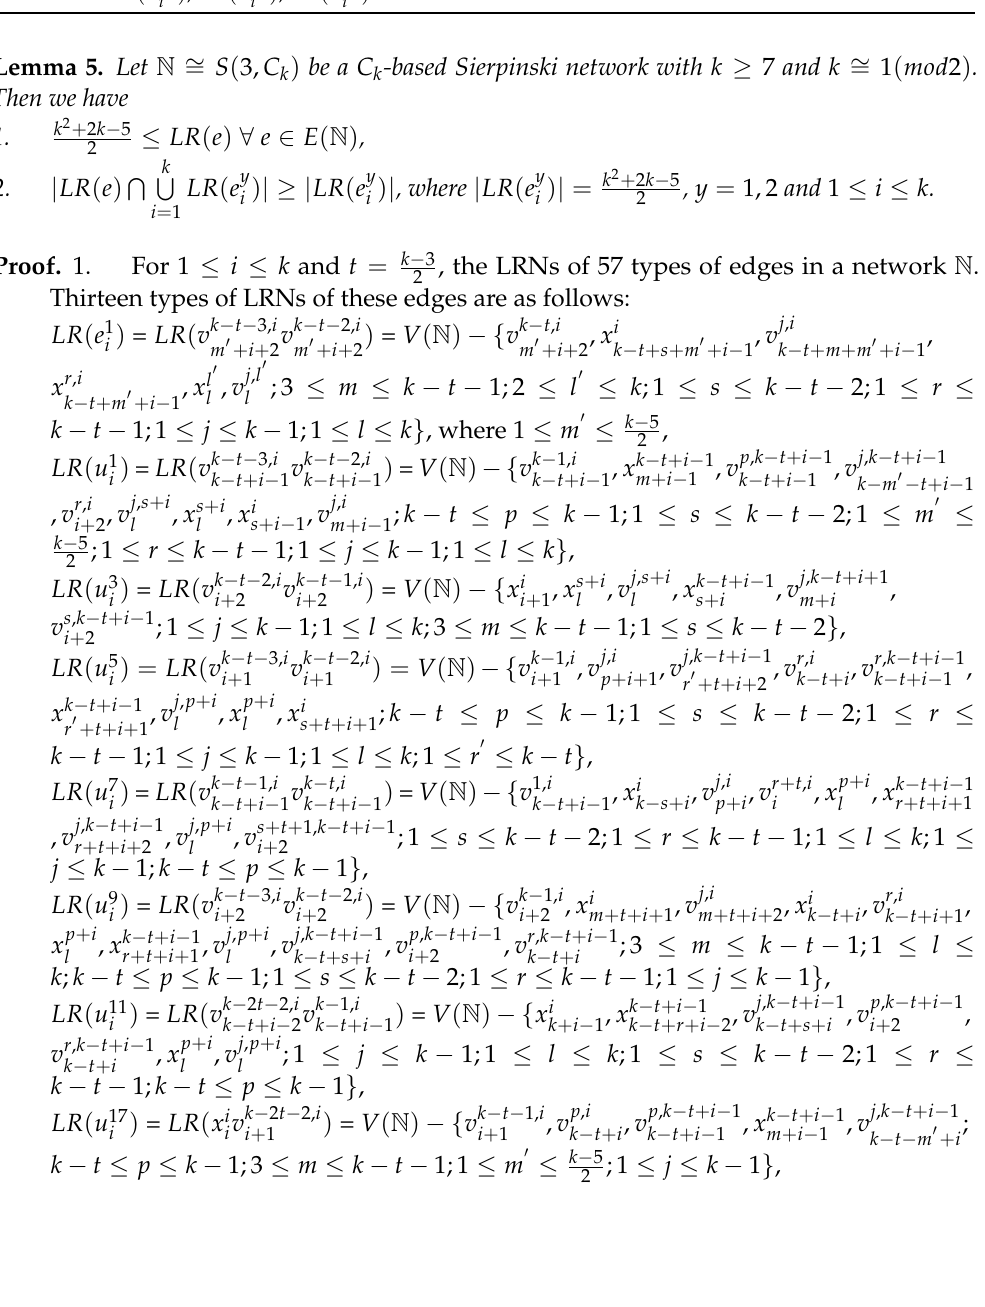
) for 1 ≤ y ≤ 2 and LR ( u z i